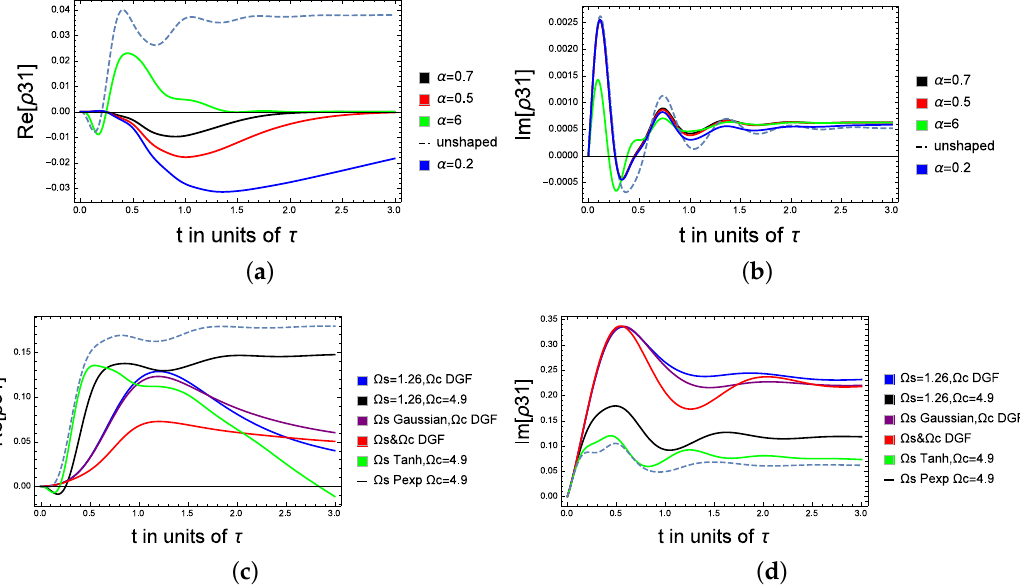
Figure 5. The probe coherence between the excited and the ground state under the effect of the microwave shaped coherence in the excited and the intermediate state: ( a ) The real part of the coherence for various shape factors α , Ω p = 0.1, ∆ p = ∆ c = 0.1. ( b ) The imaginary part of the coherence for various shape factors α , Ω p = 0.1, ∆ p = ∆ c = 0.1. ( c ) The real part of the coherence: ∆ p = 0.2 and ∆ c = 7. ( d ) The imaginary part of the coherence: